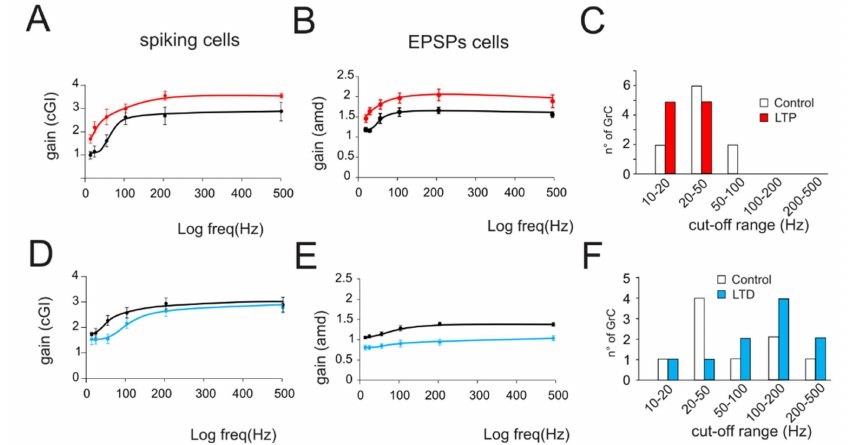
Figure 4. Average gain modulation. ( A ) Average change in cGI obtained from cells showing LTP. ( B ) Average change in the amd index obtained from cells showing LTP. ( C ) Histogram shows the number of cells showing a particular cutoff frequency in the control (white bars) and following the expression of LTP (red bars). Note the increase in low-frequency cells in response to LTP. ( D ) Average change in cGI obtained from cells showing LTD. ( E ) Average change in the amd index obtained from cells showing LTD. ( F ) Histogram shows the number of cells showing a particular cutoff frequency in the control (white bars) and following the expression of LTD (blue bars). Note the increase in low-frequency cells in response to